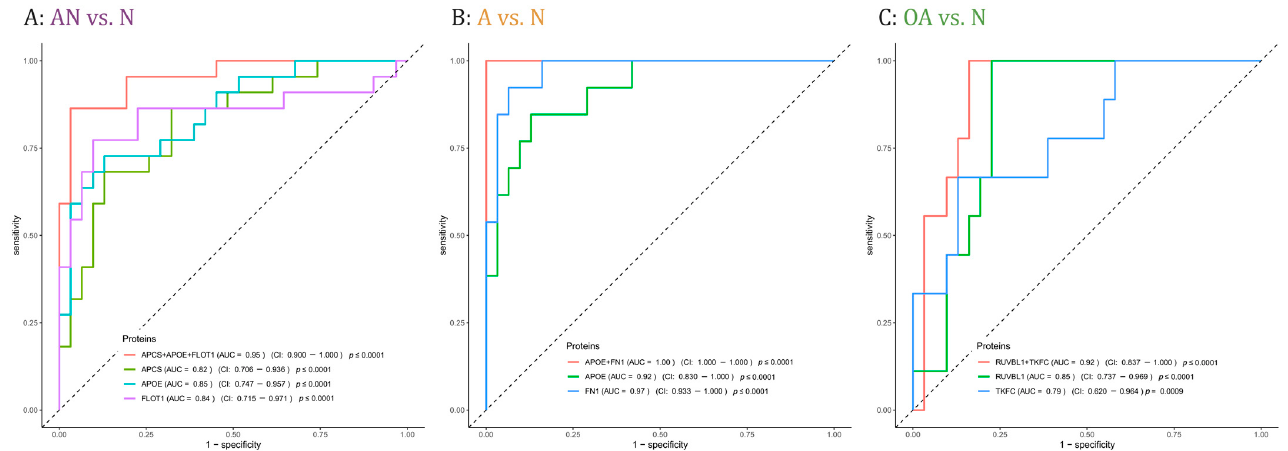
Figure 5. Receiver operating characteristic (ROC) curves comparing sensitivity and speci fi city of single proteins and protein combinations in predicting ( A ): subfertility (AN), ( B ): asthenozoospermia ( A , C ): oligoasthenozoospermia (OA) as compared to normozoospermic controls (N). Area under the curve (AUC) values, the con fi dence interval (CI), and the p -values of single proteins and protein combinations were indicated.